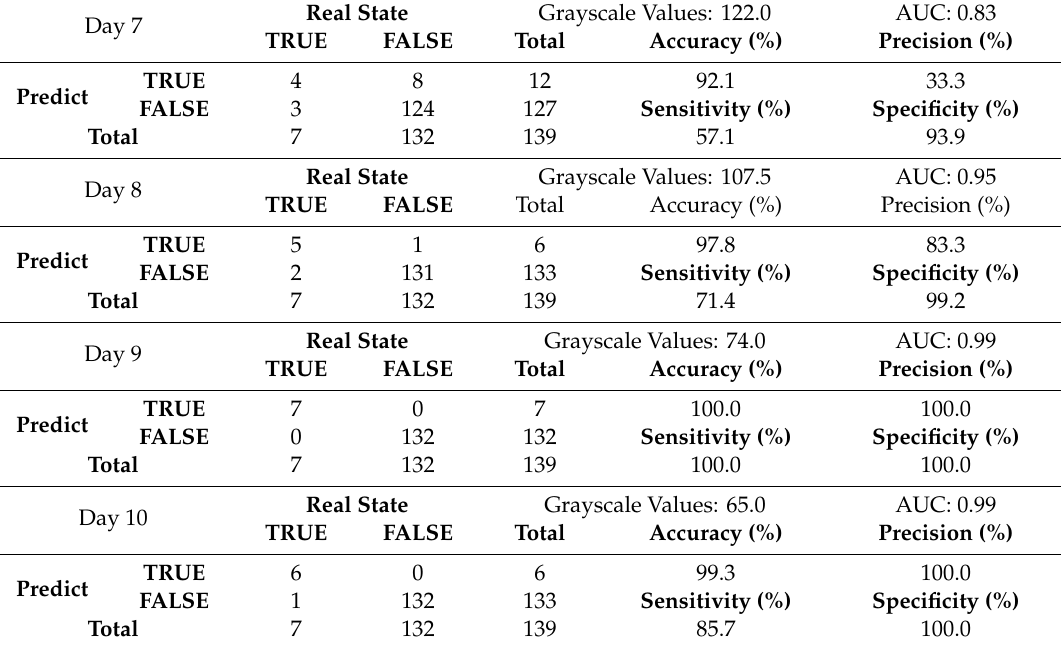
Table 4. Using detection device to identify and classify dead-in-shell eggs on the 7th–10th